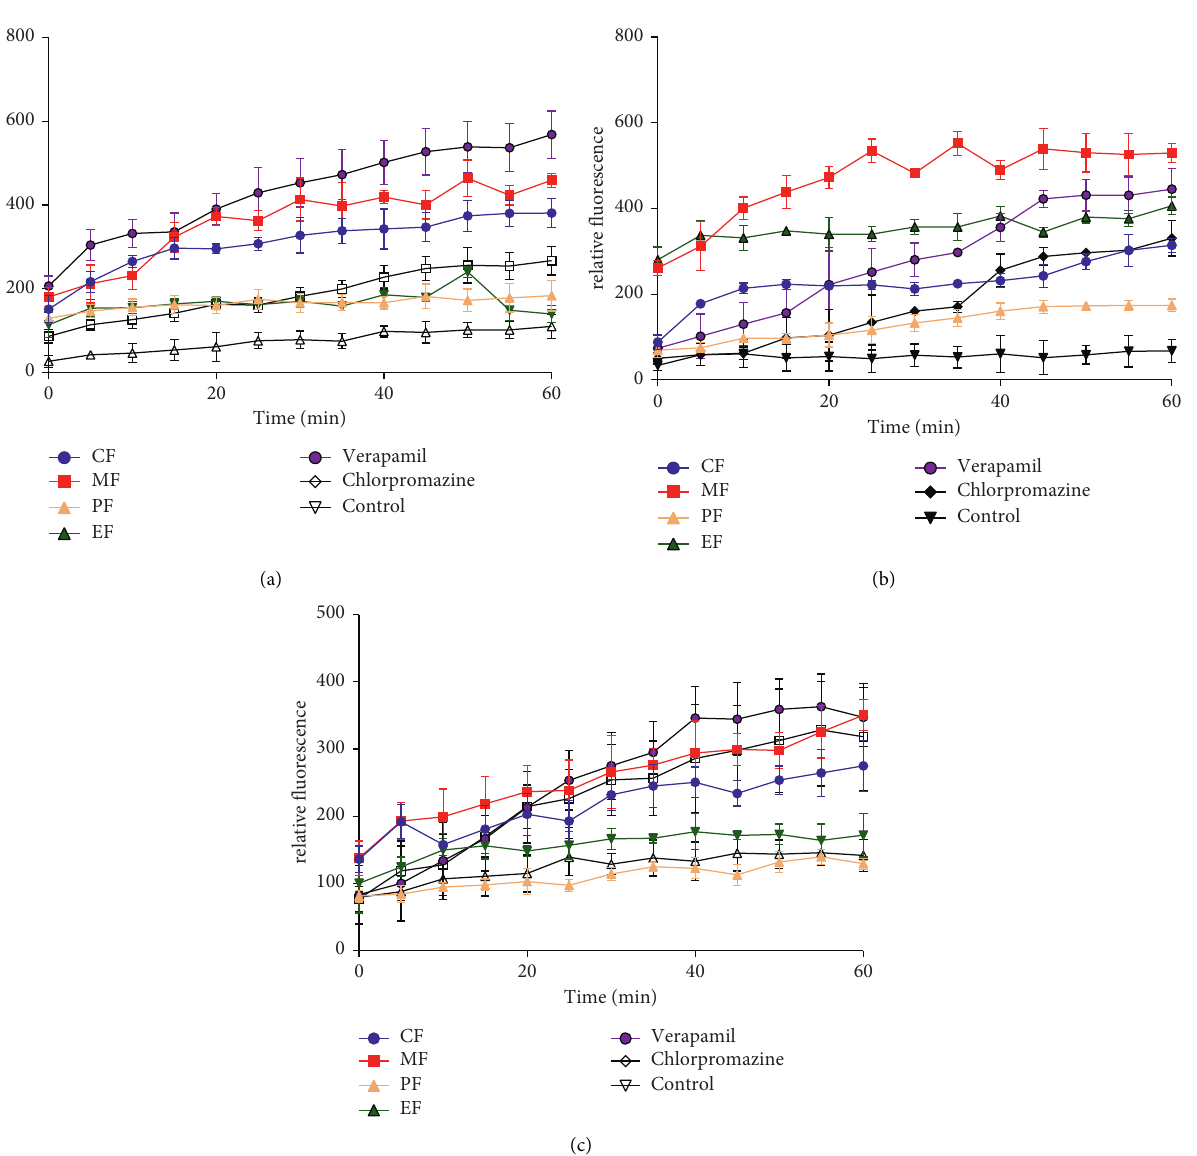
Figure 3: Efflux pump inhibition activity of the crude extract (CF), MeOH, EtOAc, and pet-ether fractions of A. macrostachya stem in S. aureus (a), E. coli (b), and P. aeruginosa